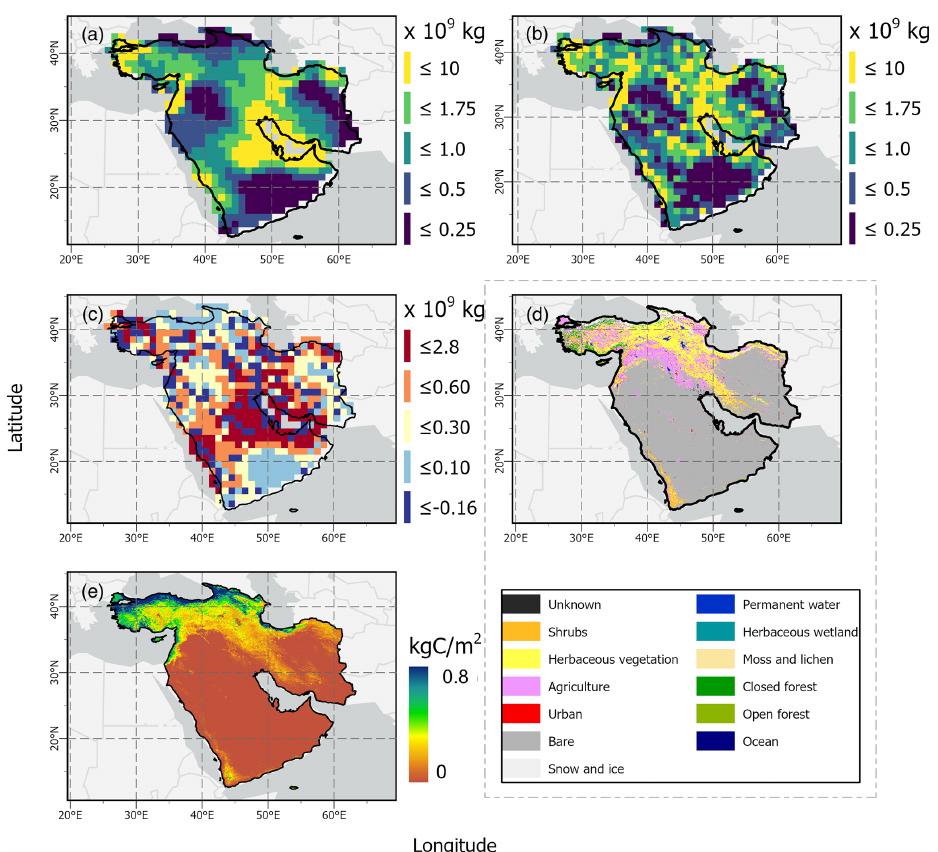
Figure 5. Spatial distribution of (a) OCO-2 XCO 2 -based anthropogenic CO 2 emission estimates for 2019, (b) actual ODIAC emissions for 2019, (c) their difference (estimated emission minus actual emission), (d) 100m resolution land cover distribution provided by the Copernicus Global Land Service over West Asia, and (e) the spatial distribution of NPP. (The base map was sourced from